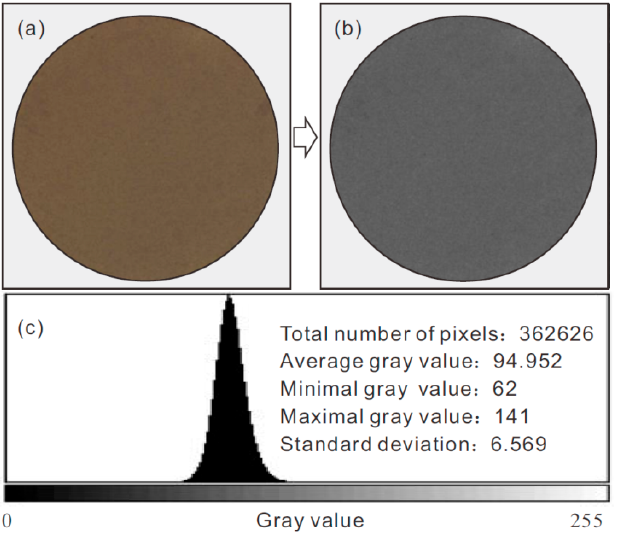
Figure 5. Conversion of color image to grayscale image and grayscale histogram: ( a ) original image of sample; ( b ) grayscale image and ( c ) image histogram representing the grayscale value distribu- tion.